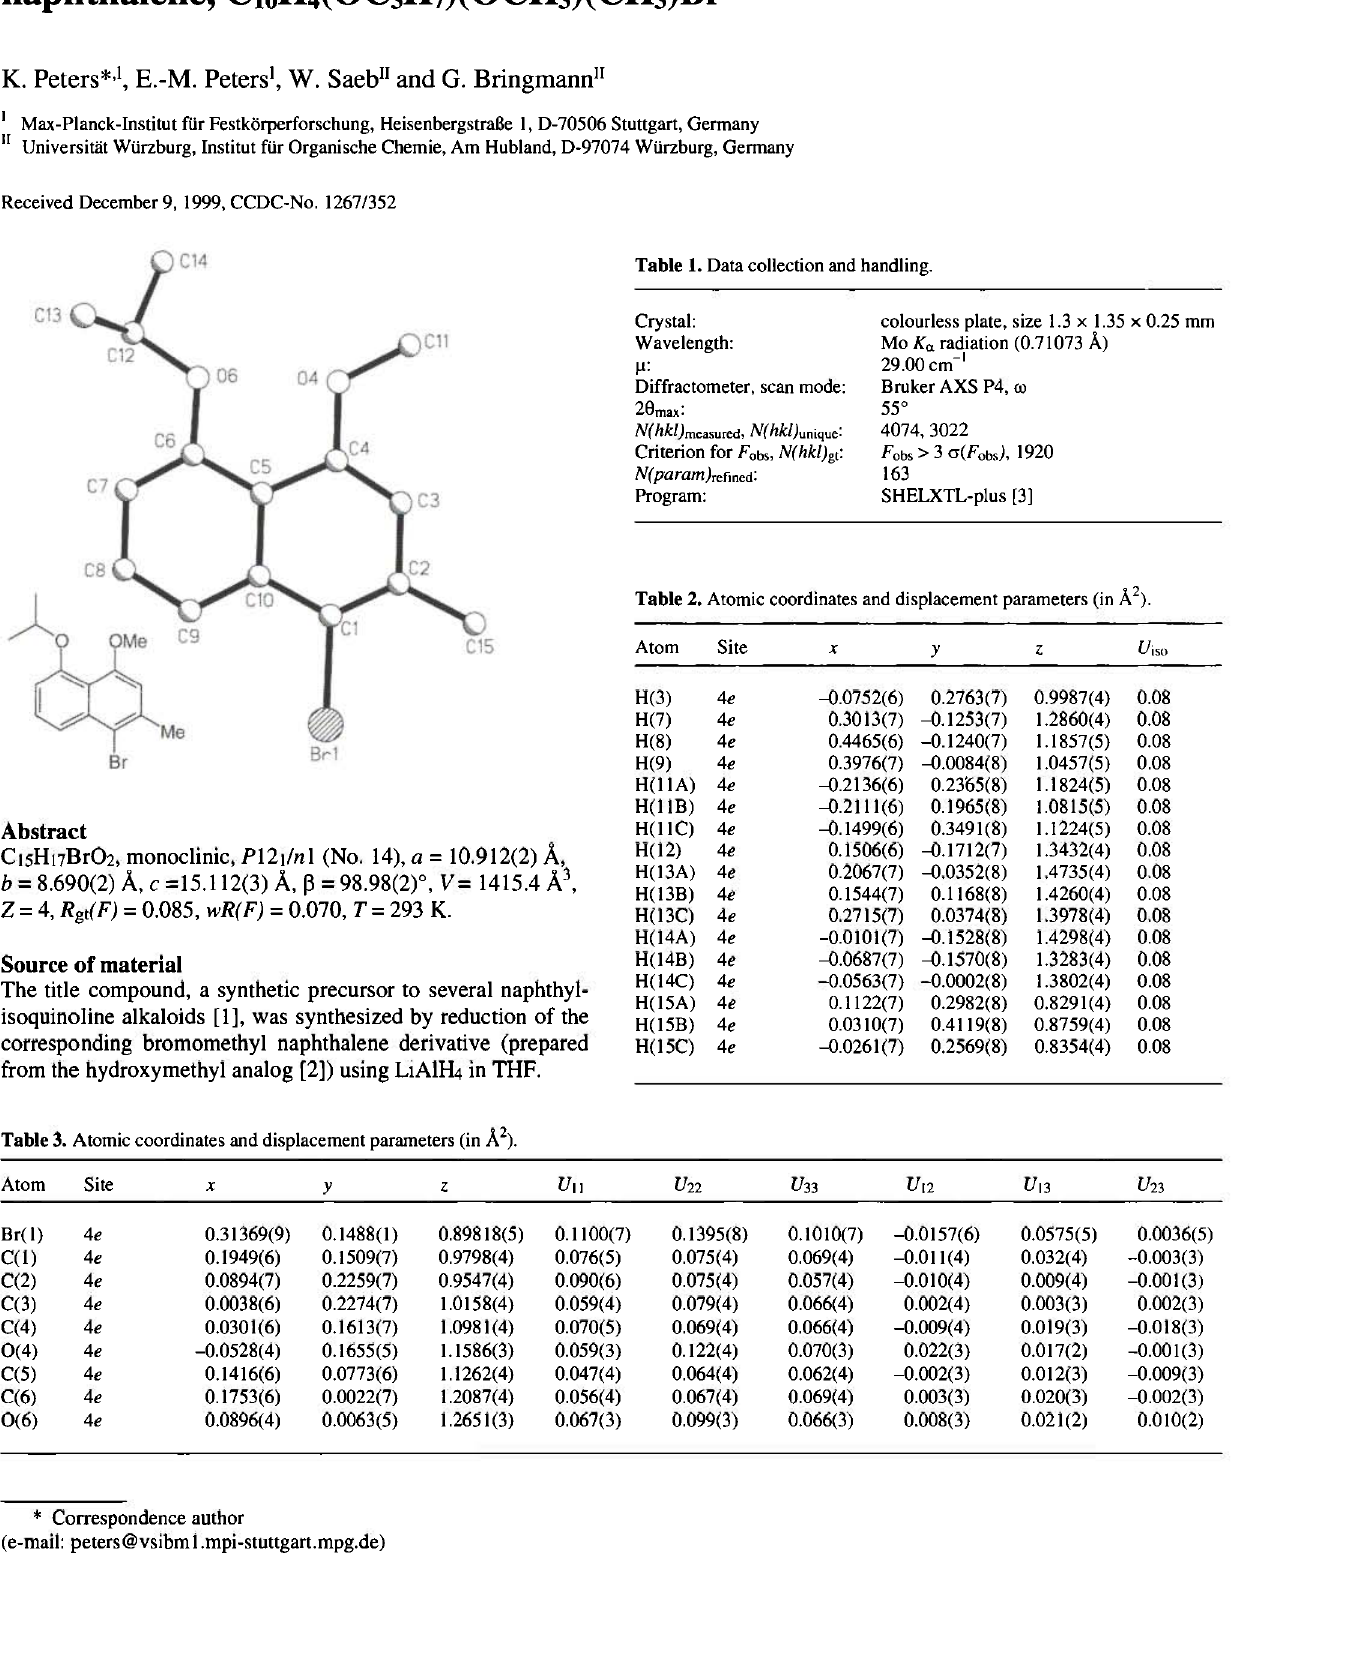
Table 1. Data collection and handling.